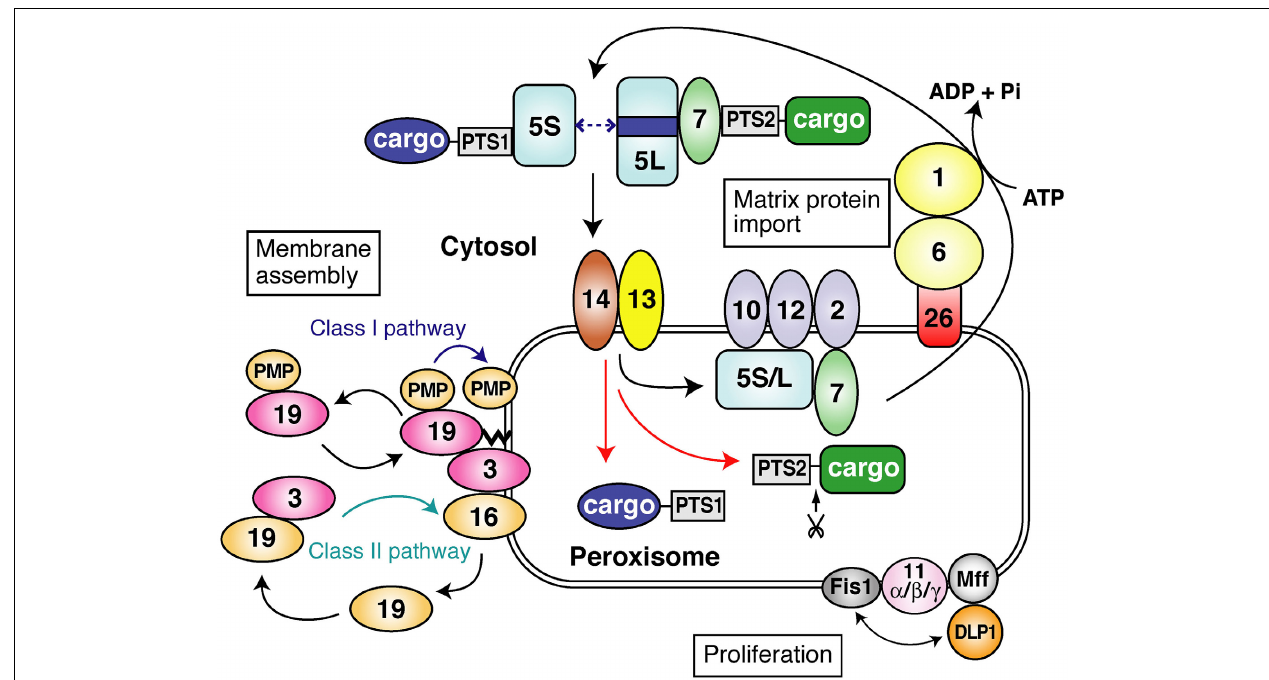
FIGURE 2 | A schematic view of peroxisome biogenesis in mammalian cells. The subcellular localization and molecular characteristics of peroxins are shown. Peroxins are classified into three groups: (1) peroxins that are required for matrix protein import; (2) those including Pex3p, Pex16p and Pex19p, responsible for peroxisome membrane assembly via classes I and II pathways (see in this figure); (3) those such as three forms of Pex11p, Pex11p α , Pex11p β , and Pex11p γ , apparently involved in peroxisome proliferation where DLP1, Mff, and Fis1 coordinately function. PTS1 and PTS2 proteins are recognized by Pex5p and Pex7p, respectively, in the cytoplasm. Two isoforms, Pex5pS and Pex5pL, of Pex5p are identified in mammals. PTS1 proteins are transported by homo- and hetero-oligomers of Pex5pS and Pex5pL to peroxisomes, where Pex14p functions as a convergent, initial docking site of the “protein import machinery” translocon. Pex5pL